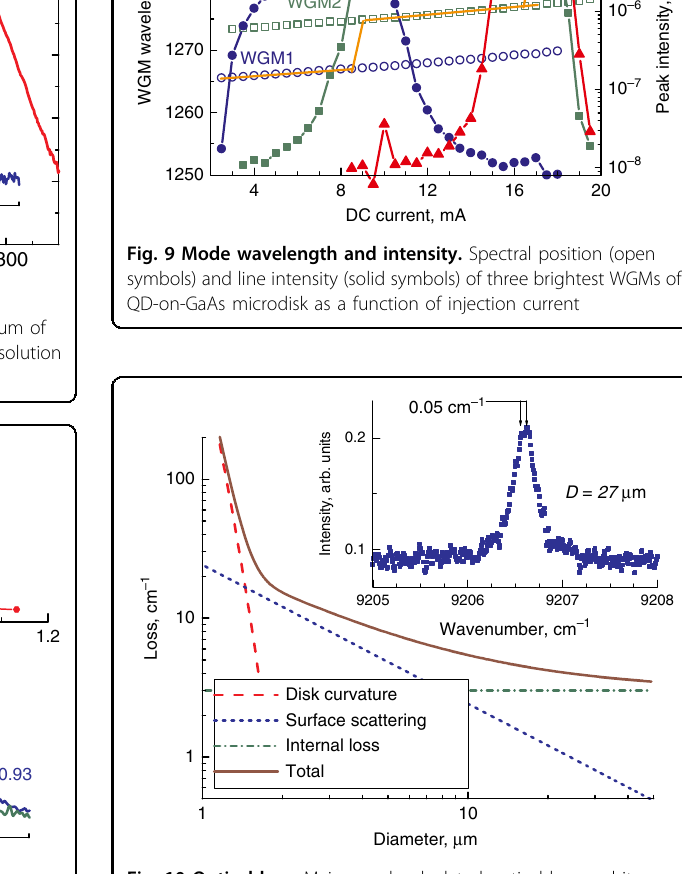
Fig. 10 Optical loss. Main panel: calculated optical loss and its components as a function of microdisk diameter. Inset: high- resolution below-threshold spectrum of QWD-on-GaAs